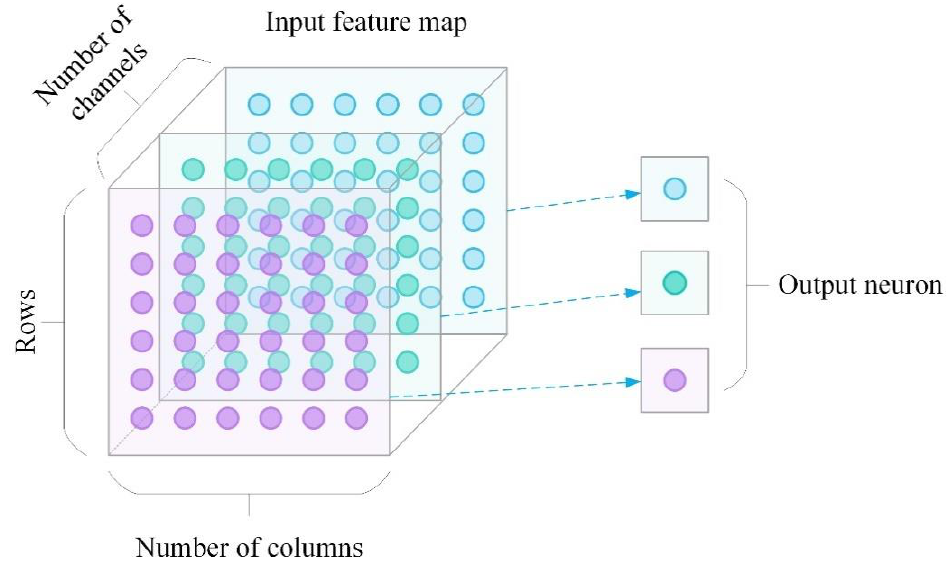
Figure 5. The schematic diagram of the global average pooling.